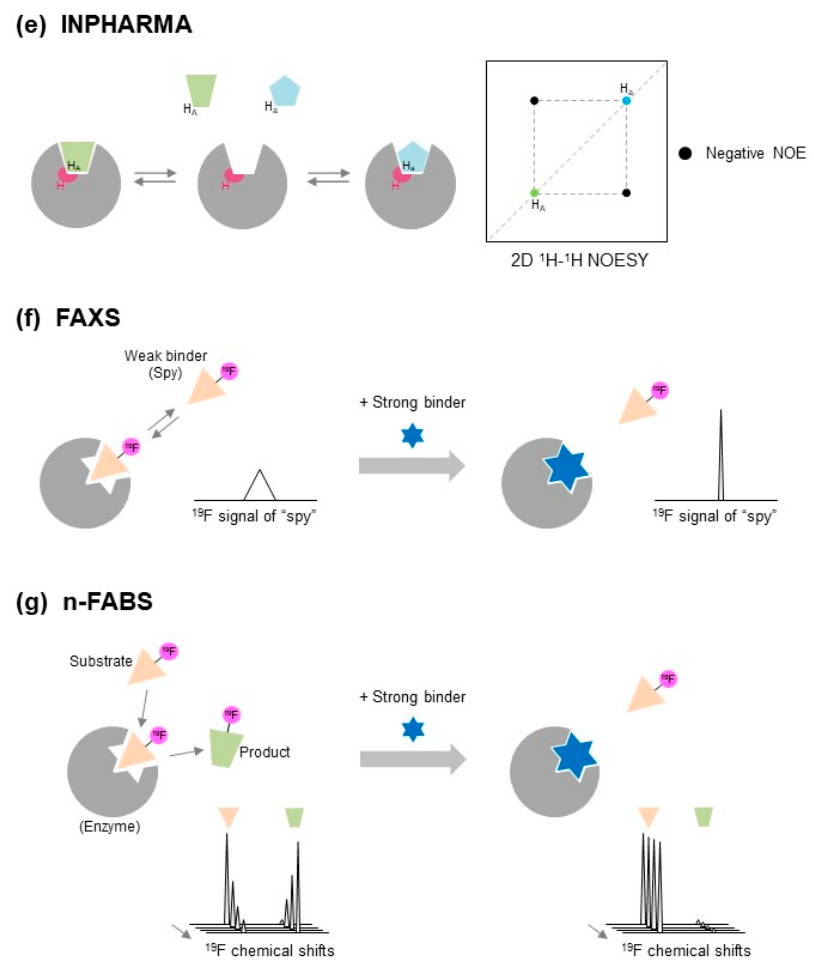
Figure 2. Ligand-based nuclear magnetic resonance (NMR) approach for structure-based drug discovery (SBDD) studies. The trapezoid, triangle, and pentagon, colored in green, pink, and light blue, respectively, indicate different compounds. The grey circle lacking the wedge shape indicates target protein. NMR spectra are taken from textbook used in “Pharmaceutical NMR Lecture Series in Osaka” held at Institute for Protein Research, Osaka University in 2012: ( a ) T 2 -filter. (Left) NMR pulse schemes for T 2 - and T 1 ρ -filtering experiments. The black and white bars indicate 90° and 180° pulses, respectively. (Right) The signal intensity of hit ligand (triangle colored in pink) is significantly attenuated by Carr-Purcell Meiboom-Gill (CPMG) or spin-lock pulse due to interaction with protein. (Bottom) 19 F T 2 -filter spectra of 19 F-chemicals (red) with and (blue) without protein; ( b ) Saturation transfer difference (STD). (Left) Pink triangle indicates hit ligand. NMR signal of the target protein is selectively saturated by radio frequency (RF) irradiation. This saturation is specifically transferred to the hit ligand (pink triangle). (Right) The signal intensity of the hit compound is significantly modulated by saturation due to interacting with protein. When the difference spectrum between the on-resonance and off-resonance saturation is observed, NMR signals from hit compounds are easily identified. (Bottom) STD spectra of the solution mixture containing L -tryptophan (as the binder), L -arginine (as non-binder), and BSA (protein); ( c ) Water-ligand observed via gradient spectroscopy (WaterLOGSY). (Left) Pink triangle and light-blue dots indicate hit ligand and water molecules, respectively. NMR signal of water is selectively saturated by RF irradiation. This saturation is specifically transferred to hit ligand (pink triangle) as intermolecular nuclear Overhauser effect (NOE) through protein-ligand complex formation. (Right) The signal of the hit ligand is reverted due to interaction with protein. (Bottom) WaterLOGSY spectra of the solution mixture containing L -tryptophan (as the binder), L -arginine (as non-binder), and BSA (protein); ( d ) Transferred NOE (trNOE). (Top Left) Pink triangle indicates hit ligand. Intra-ligand 1 H- 1 H NOE is significantly enhanced when the hit ligand is located on the target protein. (Top